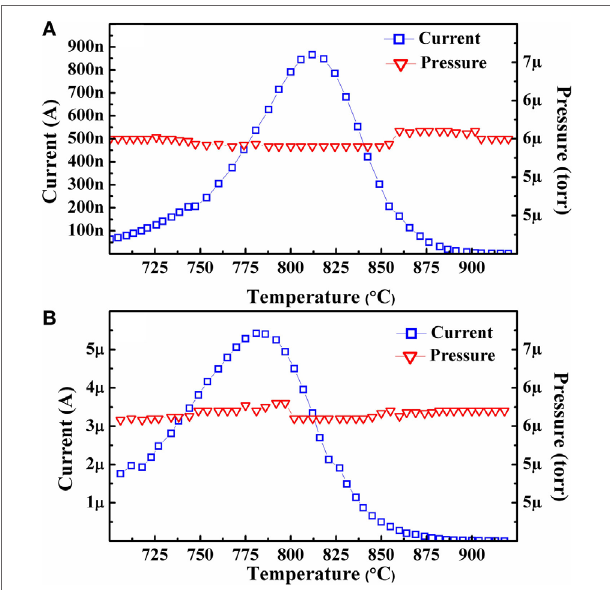
FigUre 6 | Plots of the emission current versus temperature after completion of the isothermal experiments for Sample A in the (a) as-grown and (B) hydrogenated